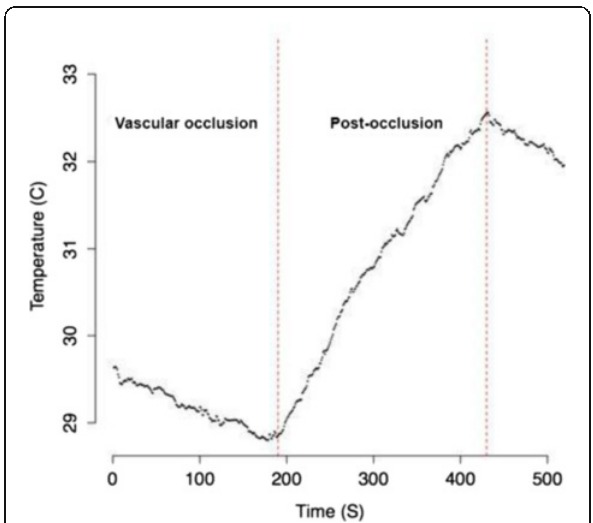
Fig. 82 (abstract A185). Palm temperature during